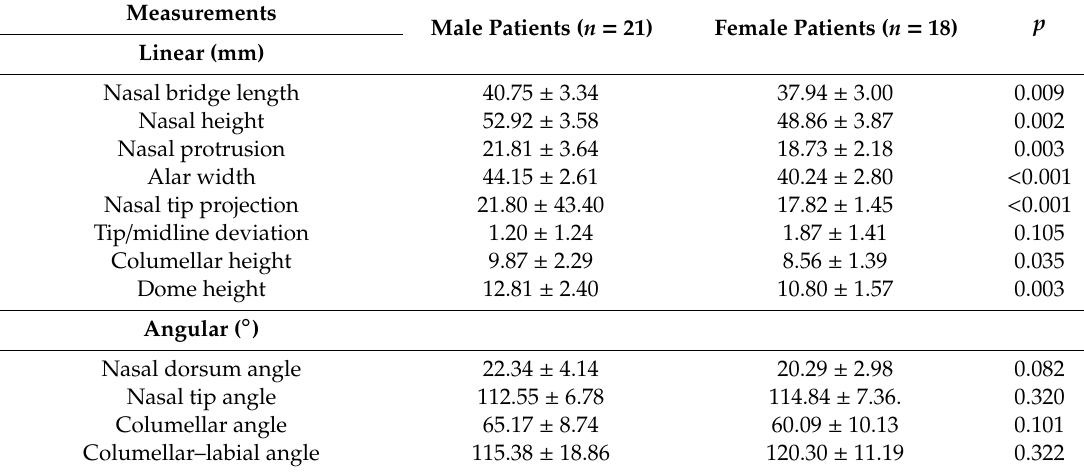
Table 3. Intragroup comparative analysis between male and female subjects in patients with bilateral cleft lip and